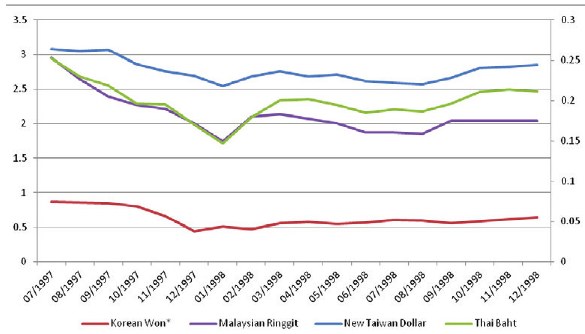
Figure 7. Exchange Rates between Hong Kong Dollar and currencies of East Asian nations between 1997:3 and 1998:4 ( source : The Hong Kong Monetary Authority) Note : * Per 100 units